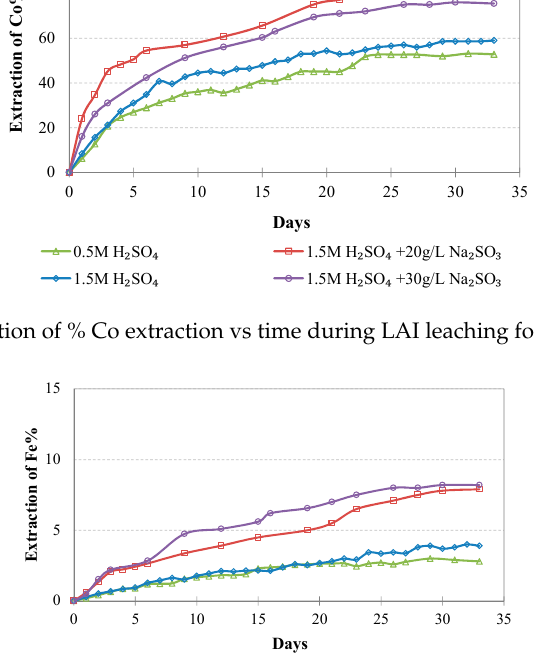
Figure 7. Evolution of % Fe extraction vs time during LAI leaching for different tests. Minerals 2018 , 8 , x FOR PEER REVIEW